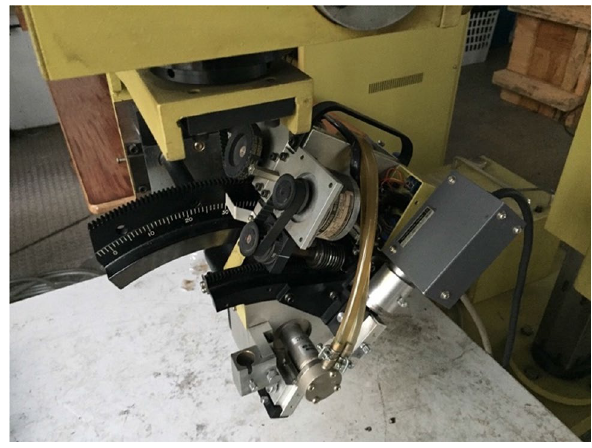
*The data bases of an internal investigation of the Spring Technol- ogy, Component Behavior and Process and has not been published